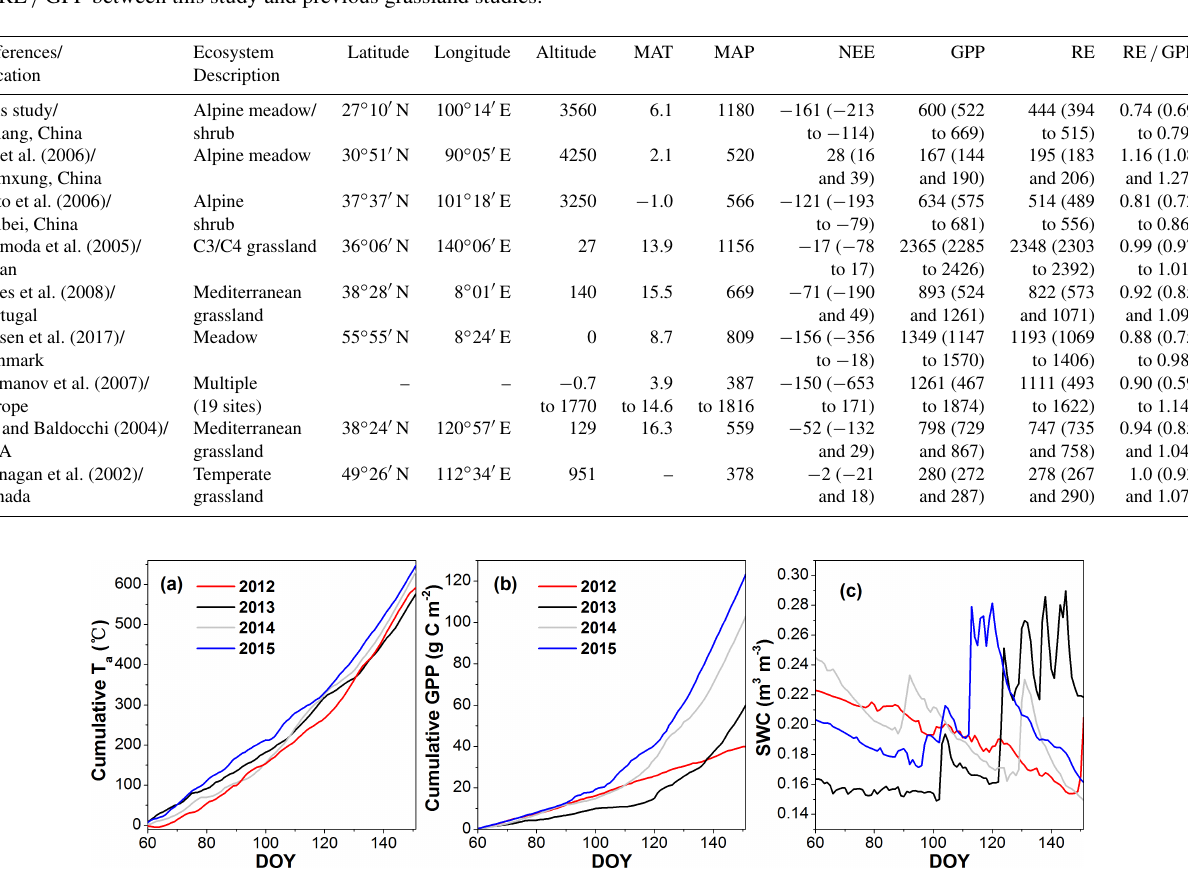
Table 7. Comparison of mean annual temperature (MAT, ◦ C), mean annual precipitation (MAP, mmyr − 1 ) , NEE (gCm − 2 yr − 1 ) , GPP, RE and RE / GPP between this study and previous grassland studies.